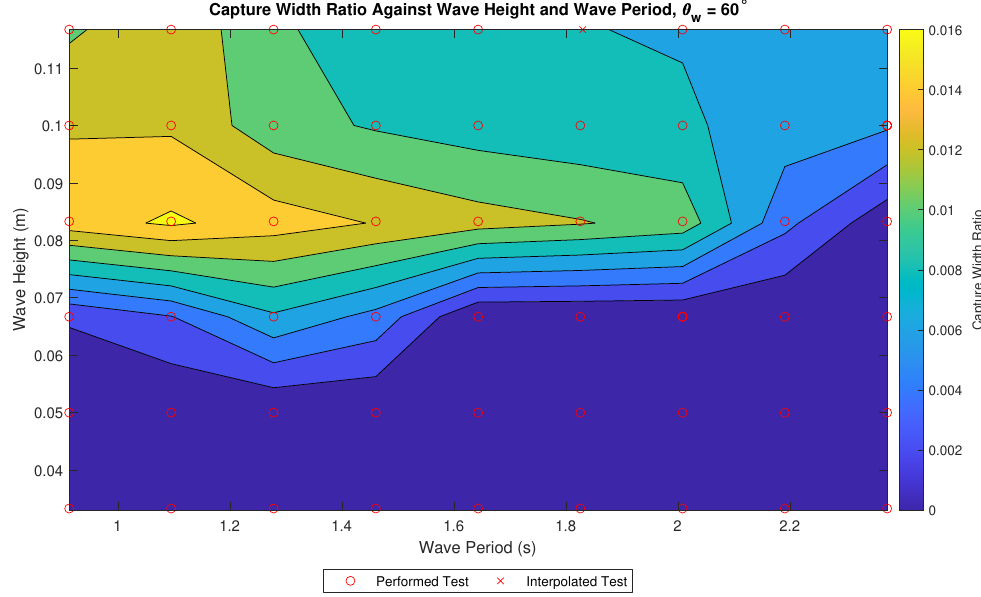
Figure 14. The CWR of the WaveCat